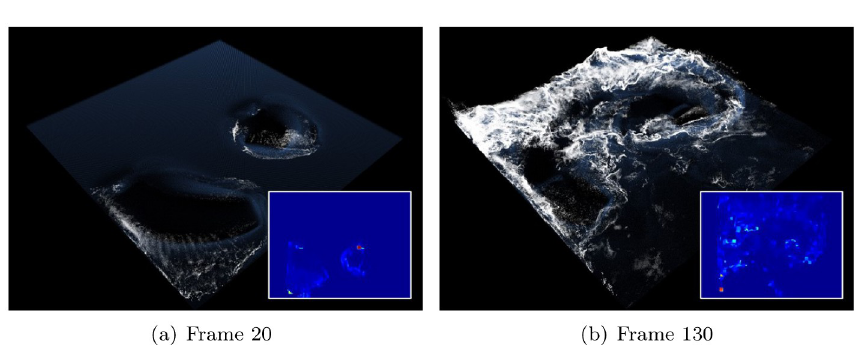
Fig 18. Foam effects with previous method and same scene as Fig 13 (inset image: Refined acceleration map with DnCNN [50]). (a) Frame 20, (b) Frame 130.